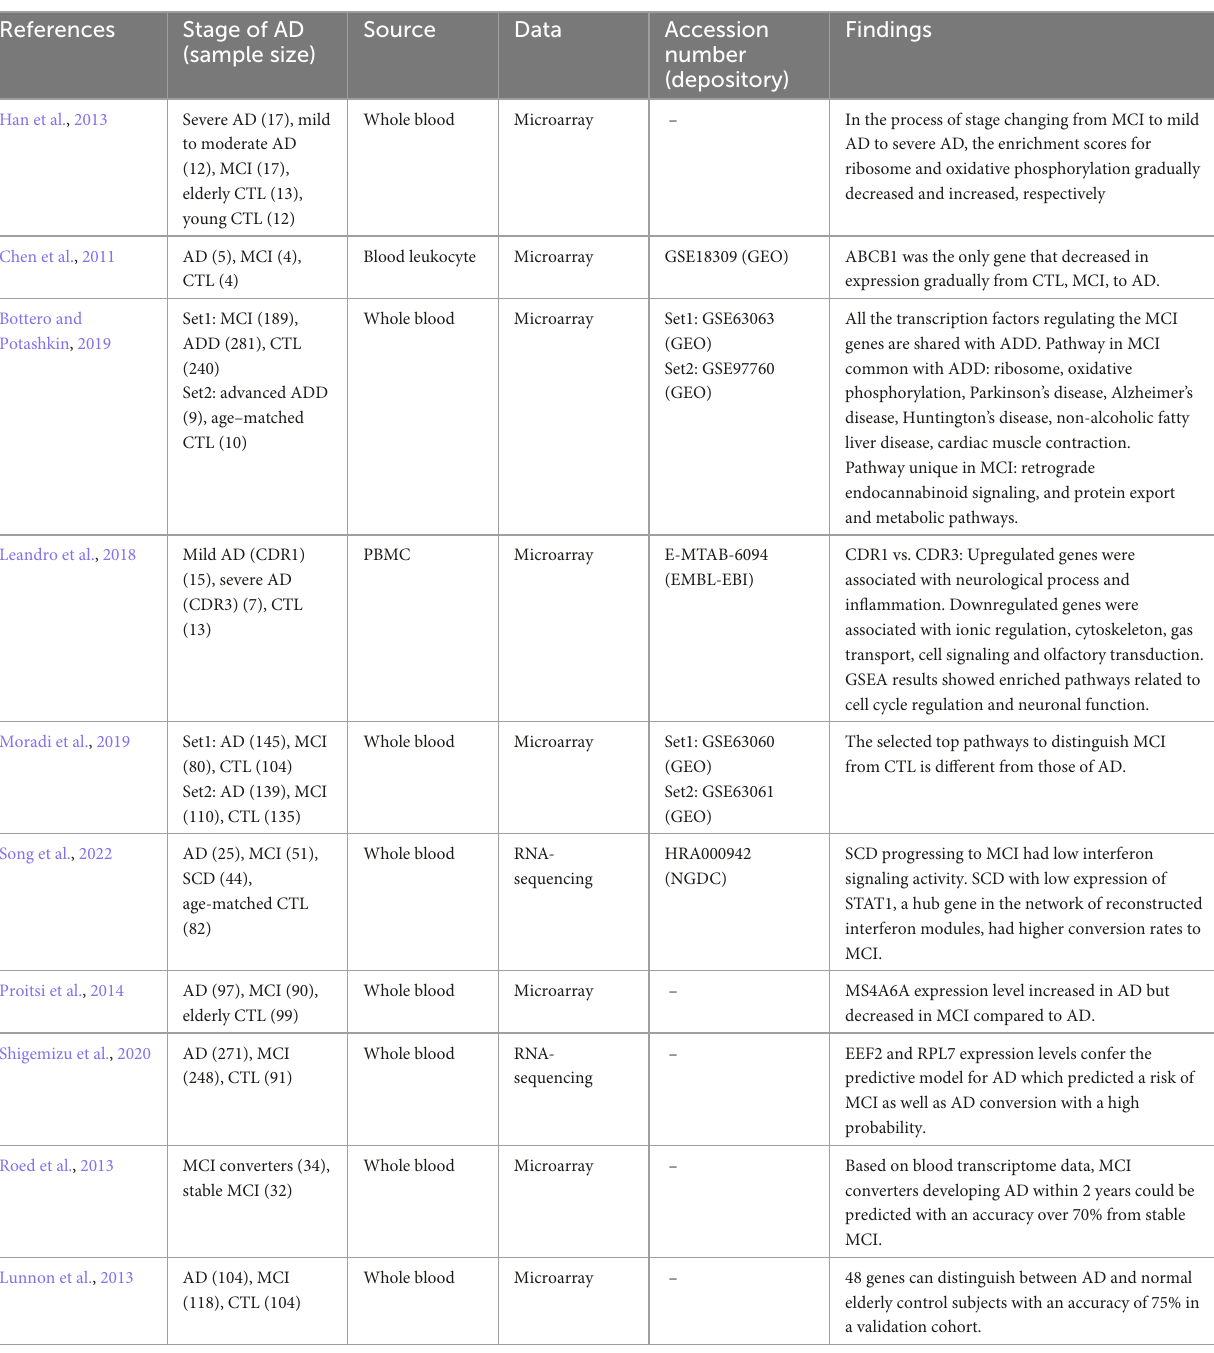
TABLE 2 Transcriptomic biomarker studies from peripheral blood of multi-time patients with cognitive